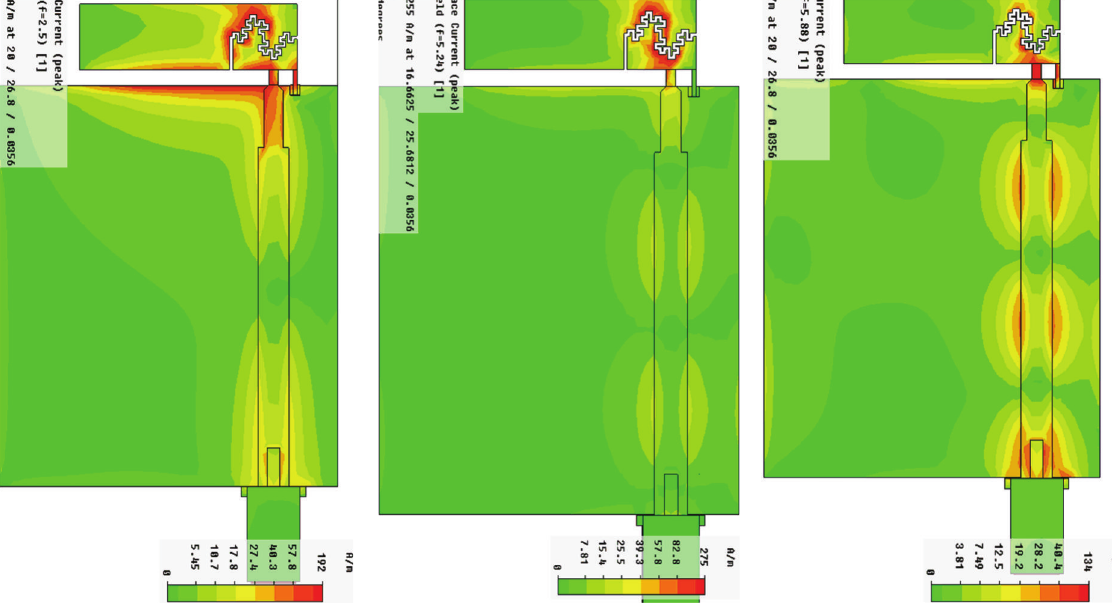
Figure 14: Surface current distributions of the dual-band MK2 PIFA at 2.5 GHz, 5.24 GHz, and 5.88 GHz. Rather, it provides the proper reactive loading (or “tuning reactance”) for a single-resonant PIFA to become dual